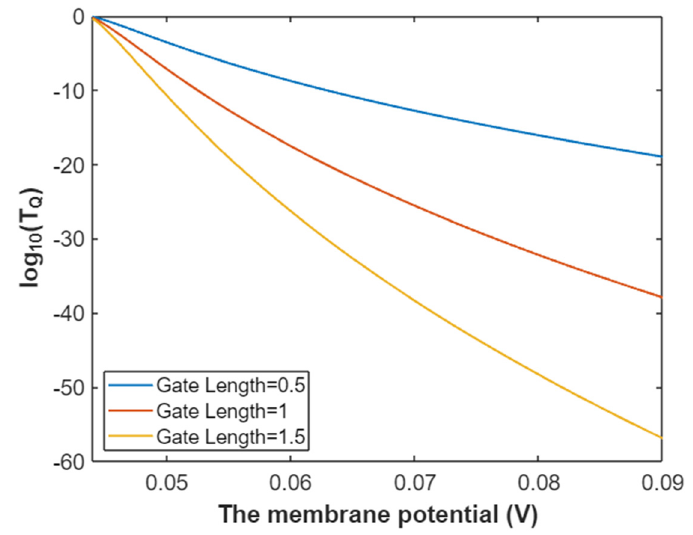
Figure 21. The relationship between membrane potential and the common logarithm of tunneling probability of extracellular potassium ions at G = 5.35 J and over a membrane potential range from 0.044 V to 0.09 V.